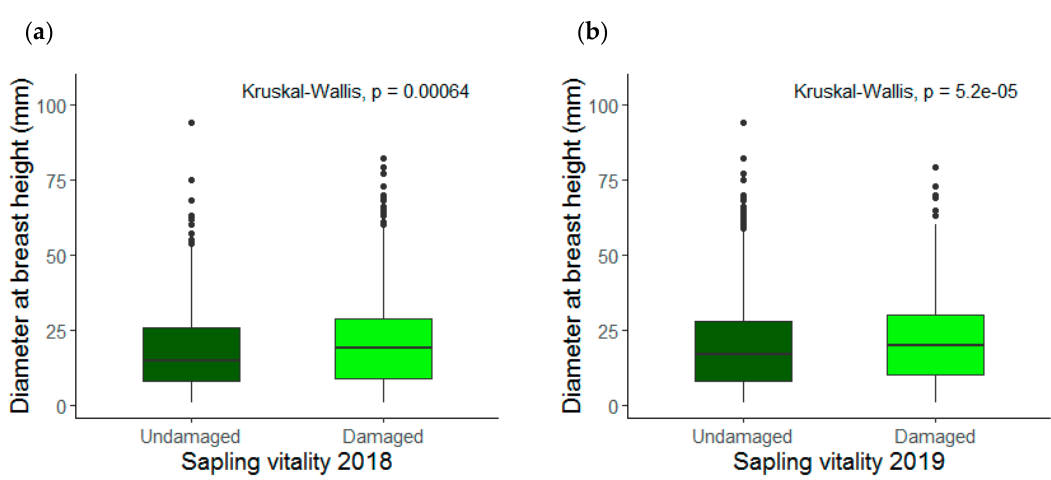
Figure 5. Shannon diversity index for all tree species and sapling vitality per plot in 2018 ( a ) and 2019 ( b ). ( c ) Sapling vitality and sapling cover (%); ( d ) Sapling vitality and mature tree cover (%). ( a ) The 53 plots undamaged and 160 damaged in 2018; ( b – d ) The 159 plots with saplings undamaged and 54 plots with saplings damaged in 2019.